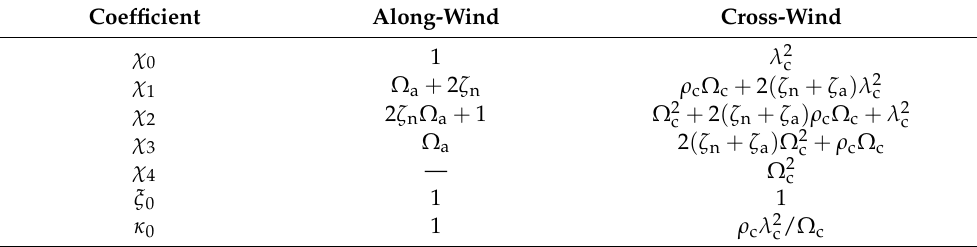
Table 4. Dimensionless filter coefficients for the uncontrolled wind-induced